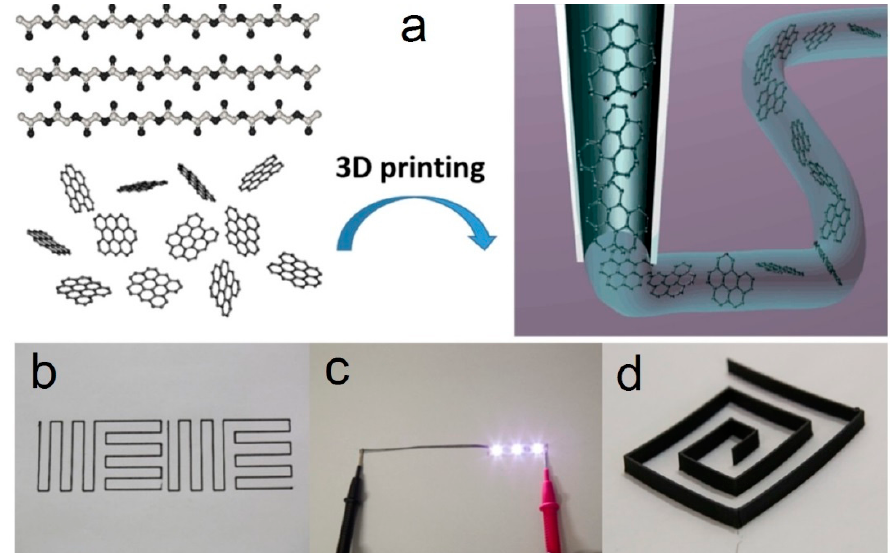
Figure 14. ( a ) Simplified schematics depicting the process of graphene-based 3D printing by FDM; ( b ) two units of 3D printed paper-based flexible circuits pattern; ( c ) LED circuit with a bunch of 3D printed filaments; ( d ) 3D printed flexible circuits. Reproduced from [201], with permission from Elsevier, 2016.